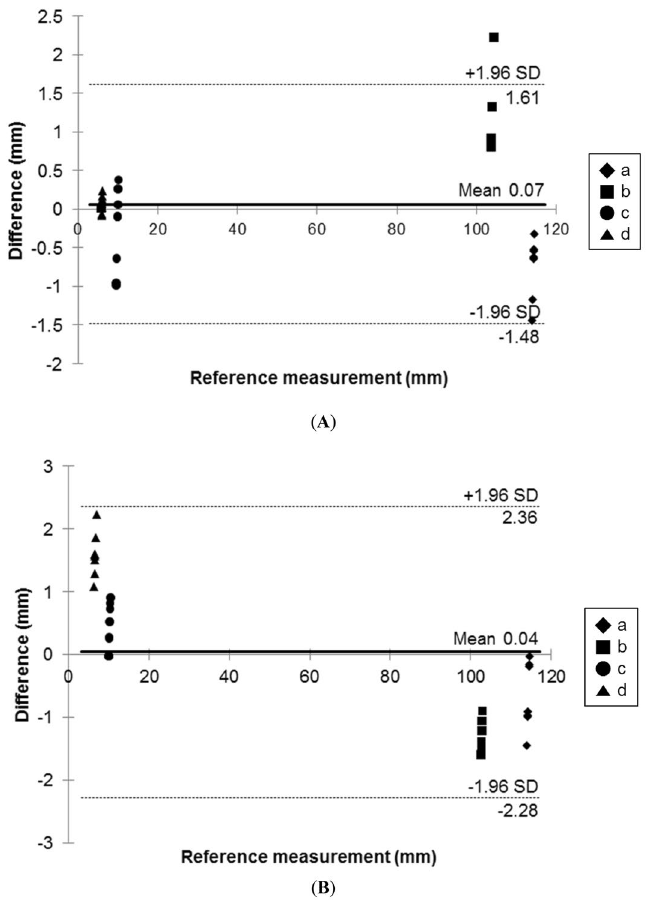
Figure 5. Bland–Altman analysis used to evaluate differences between the STL file (standard) and the two 3D-printed phantoms. ( A ) STL vs FDM, ( B ) STL vs PolyJet. The chosen landmarks were ( a ) height, ( b ) width, ( c ) diameter of VATS hole, and ( d ) diameter of another VATS hole in Fig. 4.